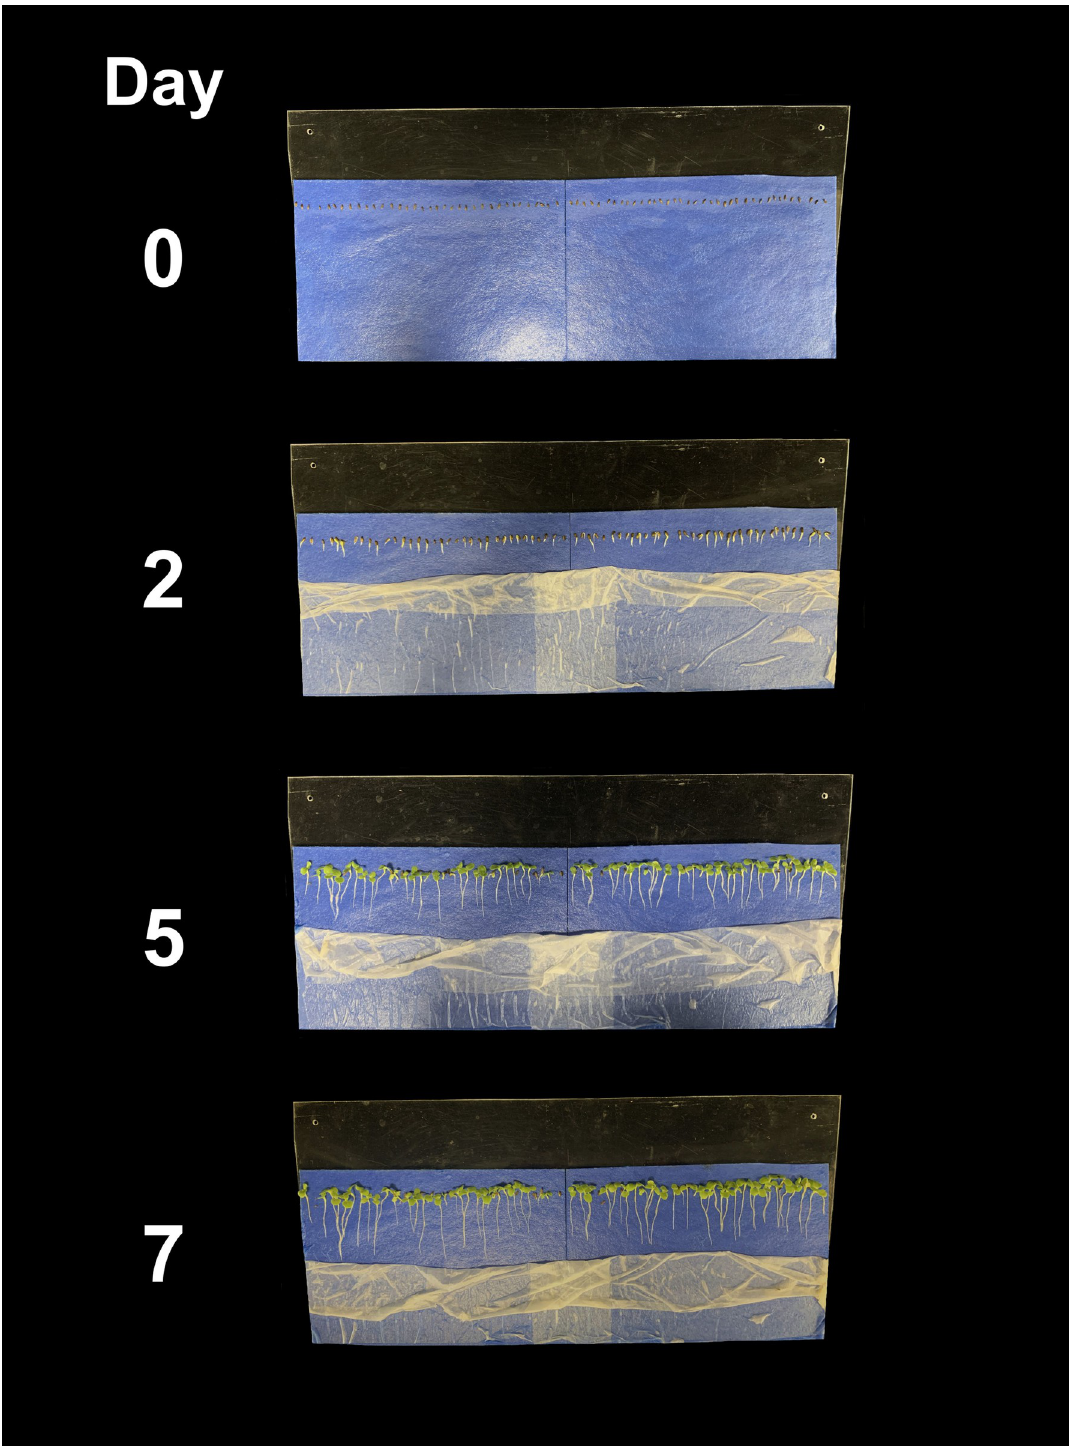
Fig 10. Slant boards with germination blotter paper, lettuce seedlings, and thin paper over the seeds from day zero to day seven post seeding. The thin paper can be removed to expose roots for inspection. Over-seeding helps for selection of uniform roots.